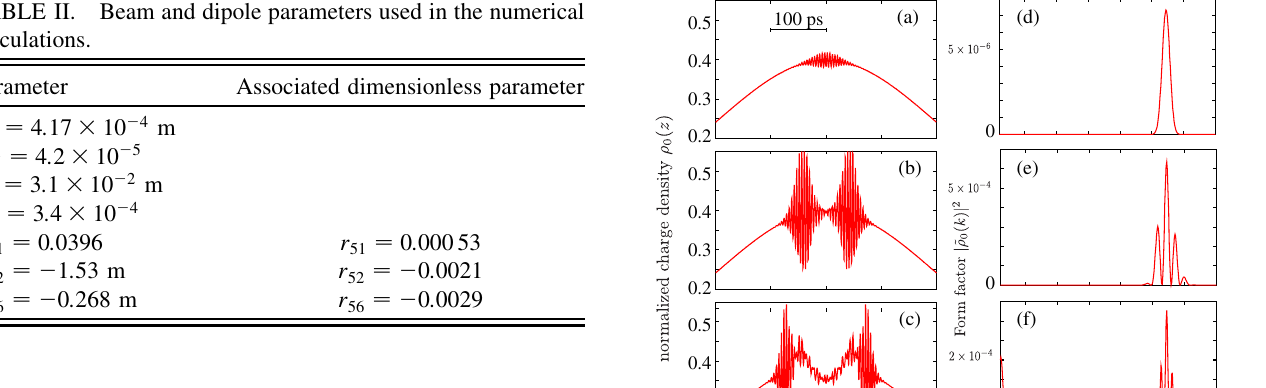
III. Parameters used in the independent calculation